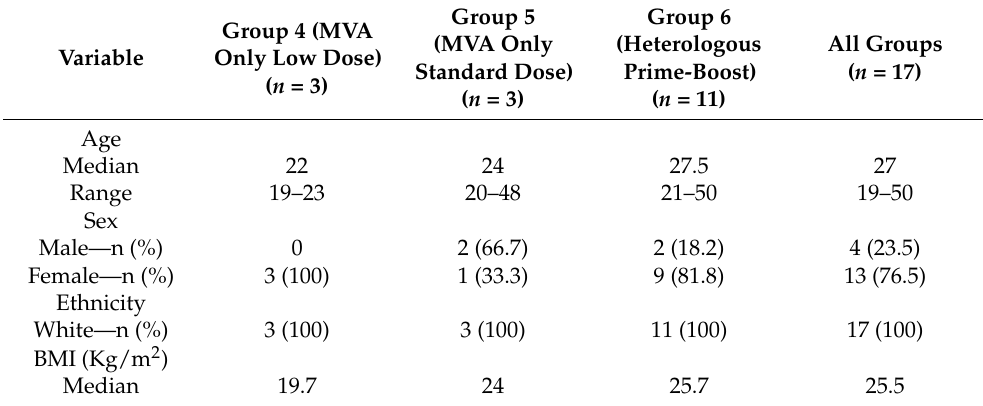
Table 1. Summary of baseline